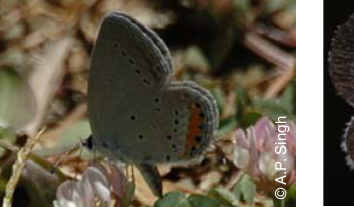
(under)Image 20. Common Hedge Blue, Acytolepis puspa -female (upper)